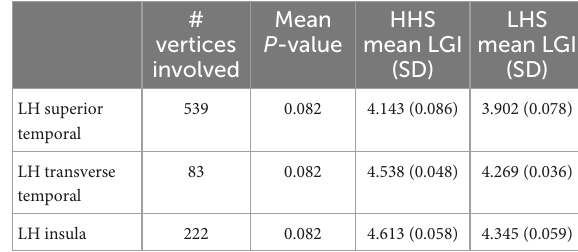
FIGURE3 LGI, between-group differences corrected for illness duration (uncorrected p results).